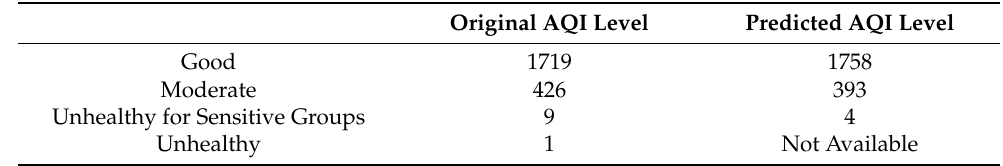
Table 9. Comparison of Original and Predicted AQI Results (created by author).